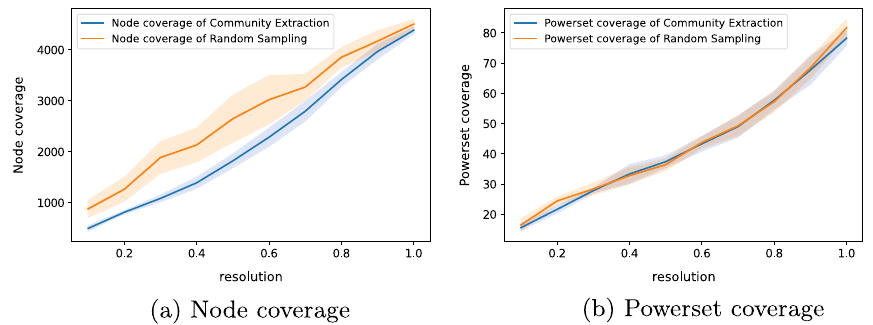
Fig. 2 Node coverage and powerset coverage between community extraction and random